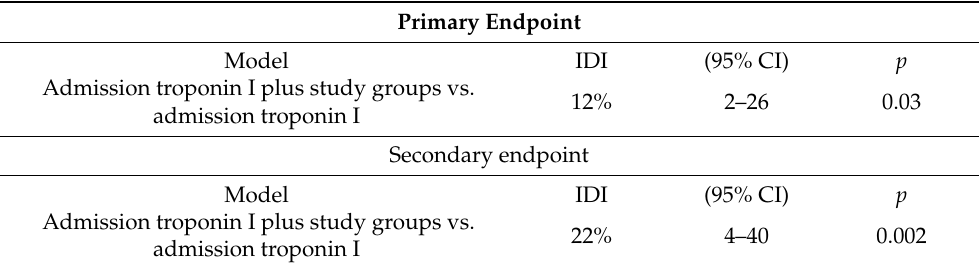
Table 2. Reclassification statistics comparison in the prediction of primary and secondary endpoints of study groups added to admission troponin